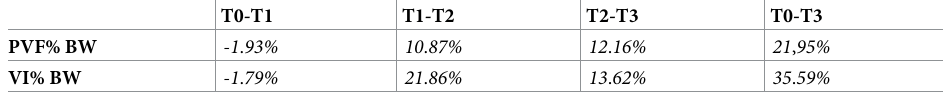
Table 3. Median percentage increment of GFRs in operated limb from T0 to